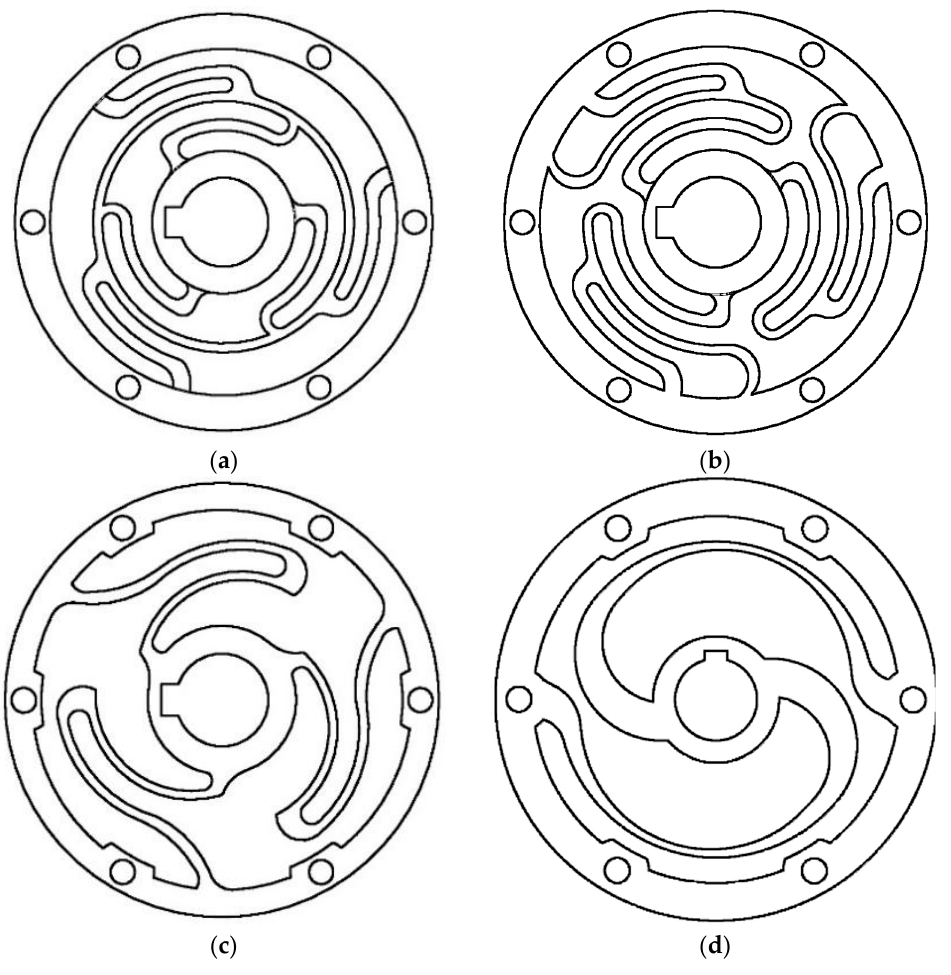
Figure 5. Elastic element module topologies considered: ( a ) Topology A; ( b ) Topology B; ( c ) Topology C; and ( d ) Topology D.